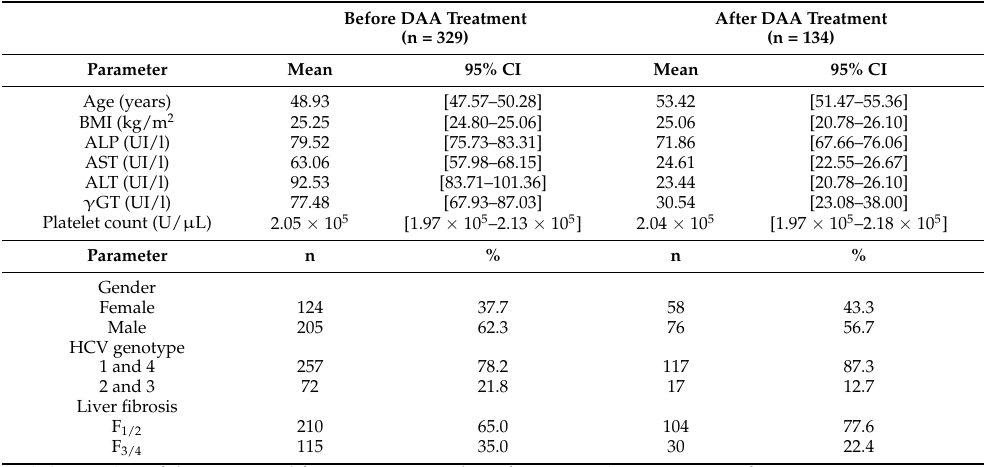
Table 9. Characterization of chronic hepatitis C patients before and after DAA